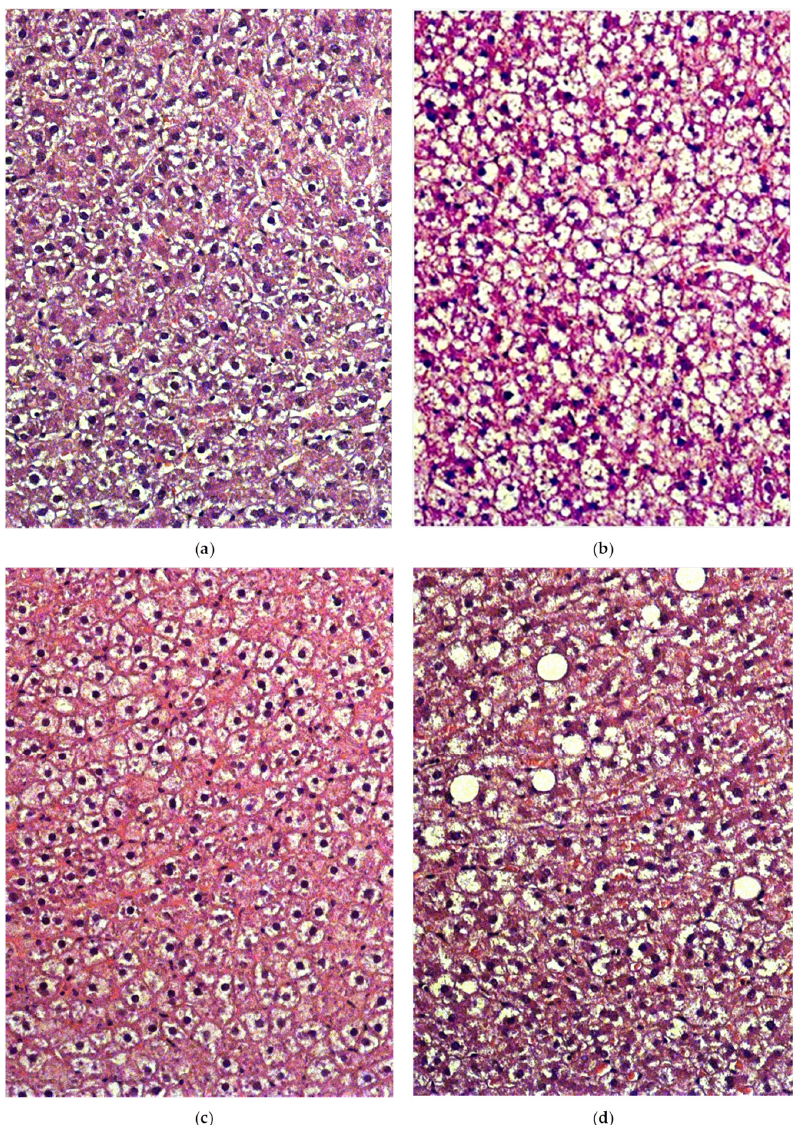
Figure 9. Light-optical micrographs of the liver sections of rats of the control group ( a ); HFCD ( b ), HFCD with tyrosine ( c ) and tryptophan ( d ). Hematoxylin and eosin stain. Magnification ×200. The numbers of animals in the groups were 4.